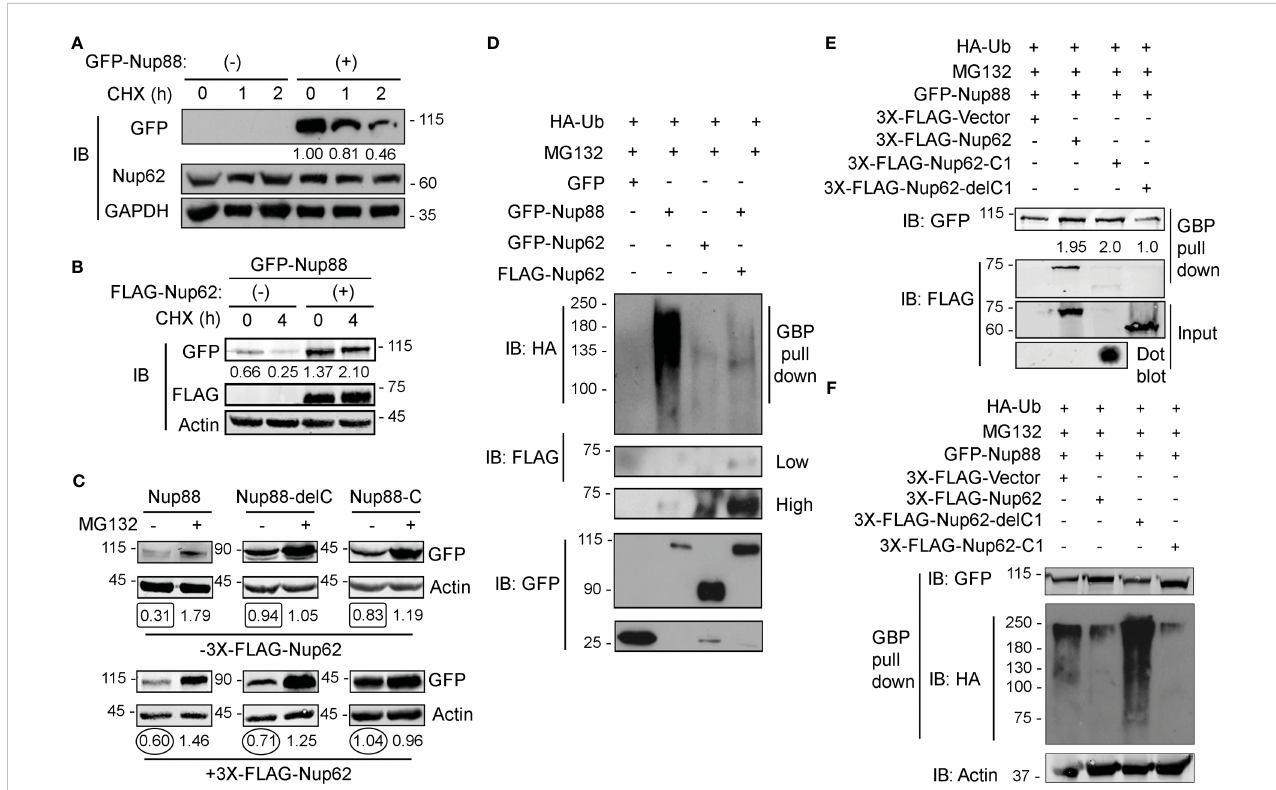
FIGURE 5 Nup62 stabilizes Nup88 protein by protecting it from degradation. (A) Detection of GFP-Nup88 in lysates of GFP-transfected and GFP-Nup88 transfected cells treated with cycloheximide for the indicated time points (h). Nup62 and GAPDH were used as internal loading controls and GAPDH for relative level quanti fi cation. (B) GFP-Nup88 transfected cells, cotransfected with 3x-FLAG-Nup62 (+), were treated with cycloheximide for the indicated time points (h). Total cell lysates were probed with anti-GFP, anti-FLAG, and anti-Actin antibodies. (C) HEK293T cells transfected with Nup88 constructs indicated on top of each panel was cotransfected with vector control (- 3X-FLAG-Nup62) or FLAG-Nup62 (+ 3X-FLAG-Nup62) and treated [(+) lanes], or not-treated [(-) lanes] with MG132 and lysates from these cells were immunoblotted with anti-GFP and anti-Actin antibodies. Values below each lane represent relative Nup88 levels quanti fi ed by normalizing the densitometry values of Nup88 with the respective loading control (Actin) using ImageJ. (D) HEK293T cells were transfected with HA-Ubiquitin and treated with MG132. These cells were cotransfected as indicated above the lanes. GBP pulldown material was immunoblotted with anti-GFP, anti-HA, and anti-FLAG antibodies. Images are a representative from at least n=3 repeat experiments. (E) HA-Ubiquitin transfected, and MG132 treated HEK293T cells were simultaneously cotransfected as indicated above the lanes. GBP pulldown material was probed with anti-GFP and anti-FLAG antibodies. (F) same as in (E) , and the GBP pull down material was probed with anti-HA, anti-GFP, and anti-Actin